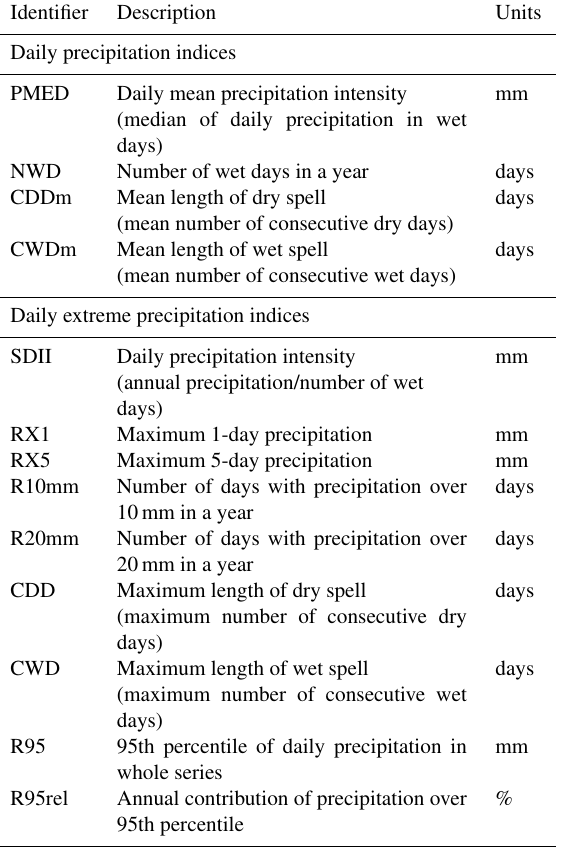
Table 2. Computed indices over daily gridded dataset. Identifier